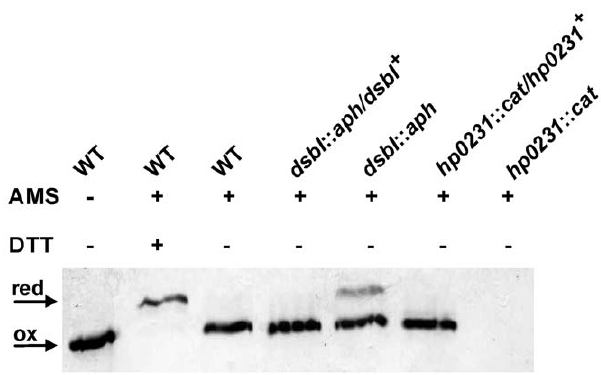
Figure 1. Redox state of HP0231 in WT, mutants: dsbI :: aph, hp0231 :: cat and complemented strains. Bacterial cultures were treated with 10% TCA, followed by alkylation with AMS. Cellular proteins including the reduced (red; DTT treated, modified with AMS) and the oxidized (ox; non-modified with AMS) controls were separated by 18% SDS-PAGE under non-reducing conditions, and Western blot analysis using antibodies against HP0231 was performed. Each lane contains proteins isolated from the same amount of bacteria.